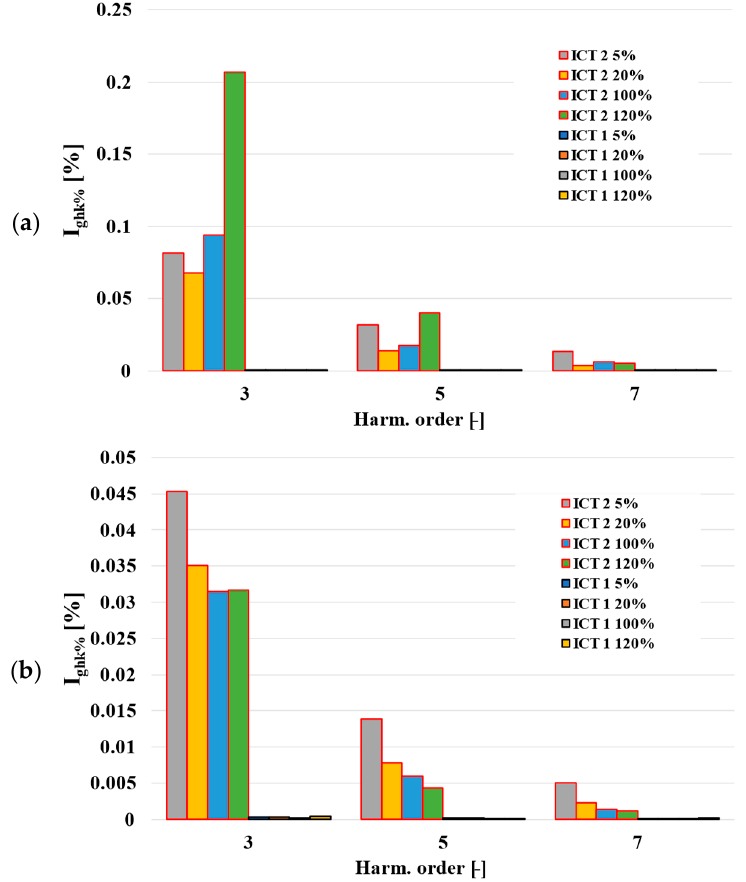
Figure 7. Comparison of determined values of self-generated low-order higher harmonics for both tested CT for rated ( a ) and 25% ( b ) of the rated load of the secondary winding.